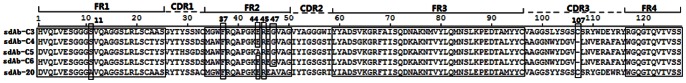
Multiple amino acid sequence alignment of FMDV Asia 1 specific sdAbs antibody clones.Amino acid sequences were aligned according to the Kabat numbering. The specific VHH amino acids were thick-lined boxed, the FRs were thin-lined boxed.